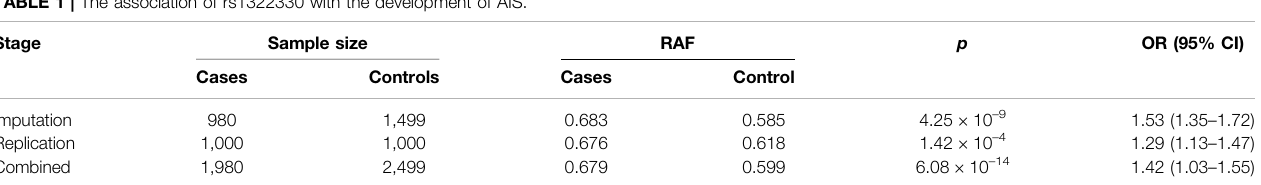
RAF, risk allele frequency; OR, odds ratio; CI, con fi dential interval.